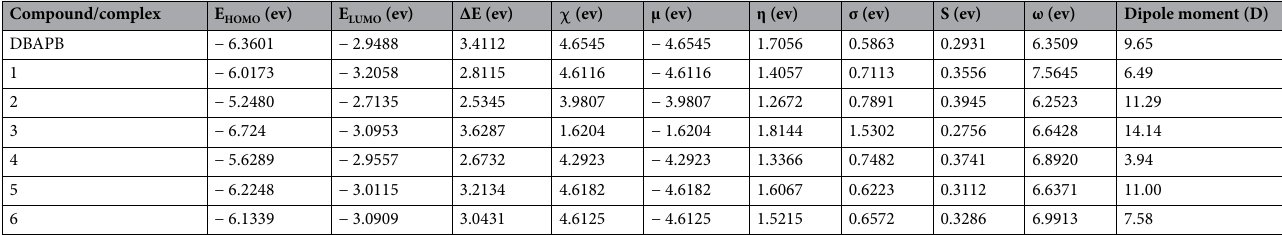
Table 7. Evaluated quantum chemical parameters of the ligand, DBAPB, and its metal